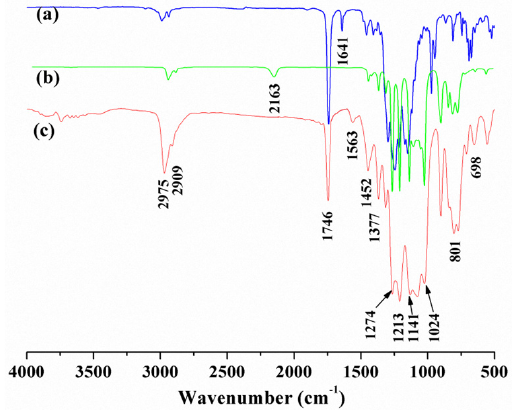
Figure 1. IR spectra of ( a ) fluoroalkyl acrylate (FA), ( b ) polytrifluoropropylhydromethylsiloxane (PFHMS), and ( c ) PFAS.